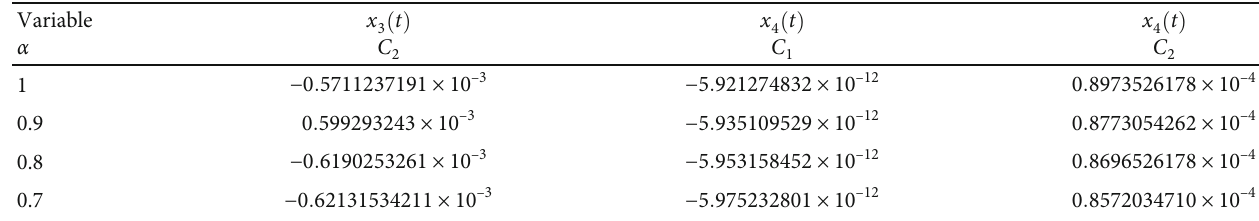
at di ff erent values of α . k